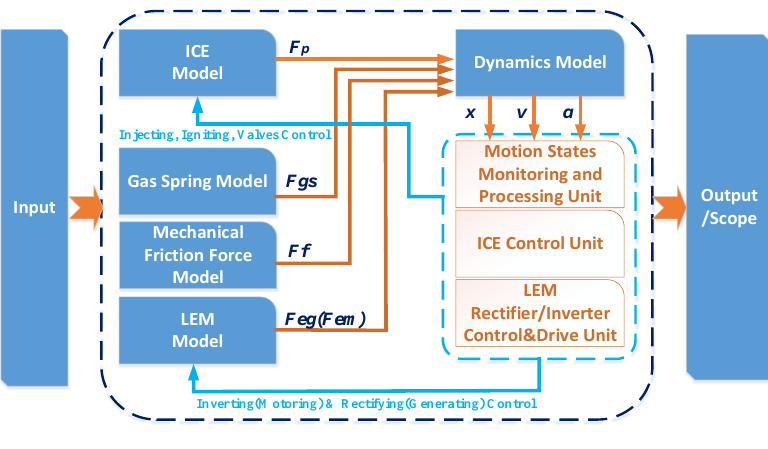
Figure 13. Simulation model diagram. Table 7. Crucial simulation conditions.